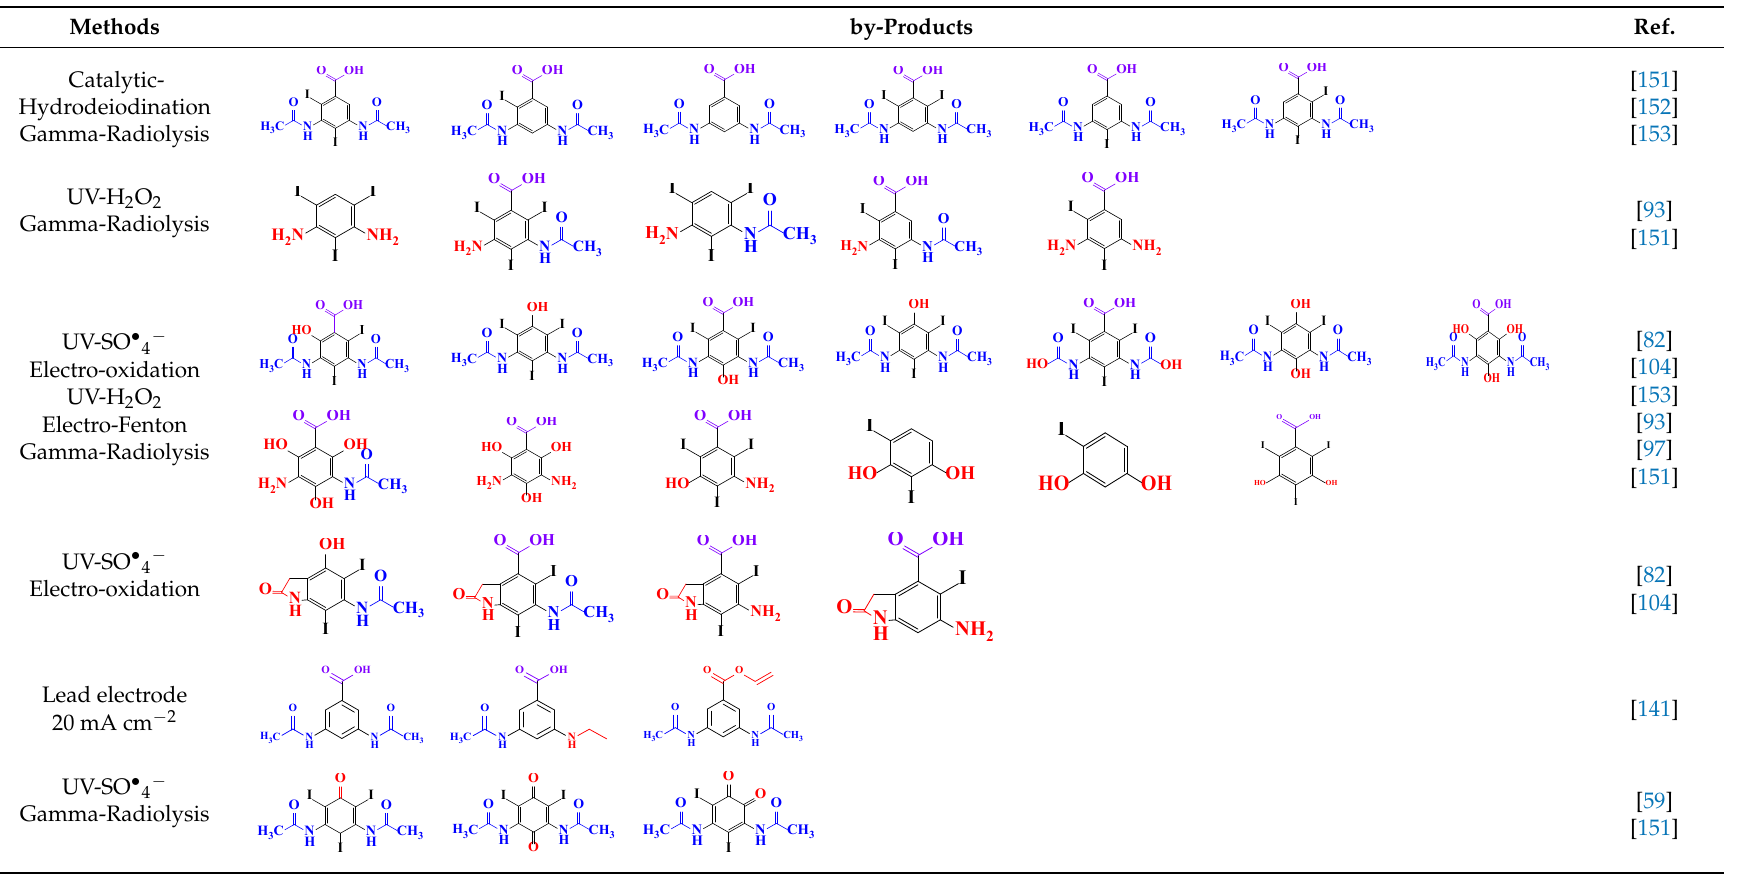
Table 5. Identified by-products of diatrizoate in recent literature.